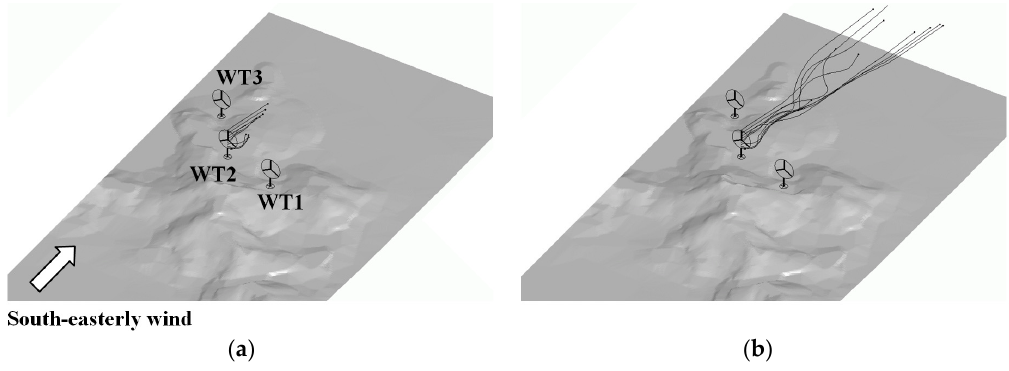
Figure 15. Trajectories (pathlines) of virtual particles released from the location of WT2. Virtual particles are released at the y-coordinate of the center of the wind turbine hub, across a straight line between the lower and upper ends of the swept area. ( a ) At non-dimensional time, t. ( b ) At non-dimensional time, t + Δ t.